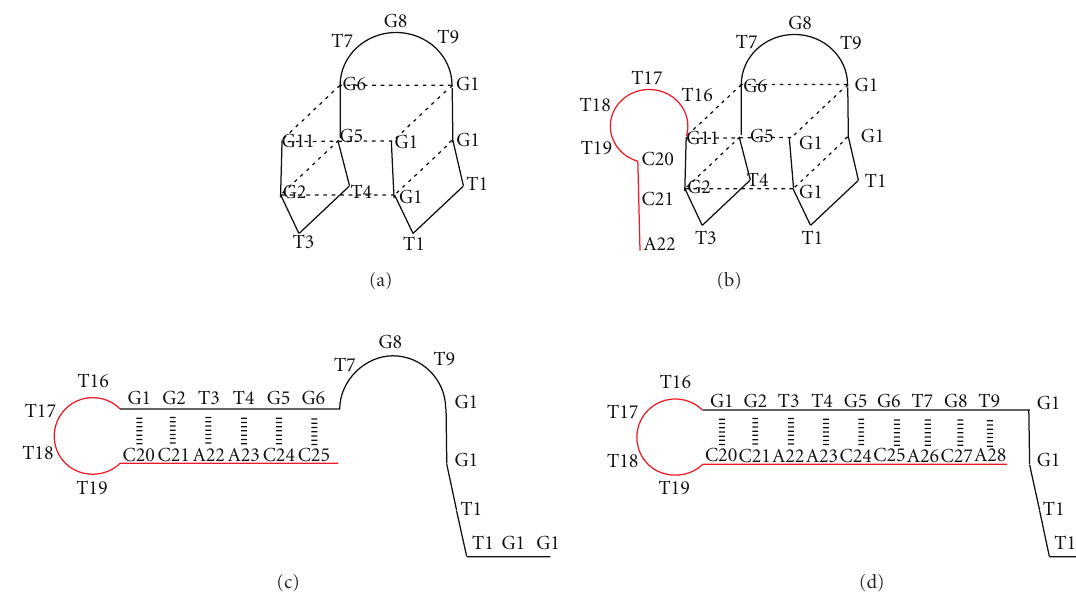
Figure 3: Schematic representation of the structure of several derivatives of thrombin-binding aptamers (TBAs) prepared in this study. TBA sequence is shown in black, and T4 loop with di ff erent sizes of the complementary sequences are shown in red. (a) Native TBA; (b) TBA-hairpin containing three overhanging complementary nucleotides (3-HP-TBA); (c) TBA-hairpin containing six overhanging complementary nucleotides (6-HP-TBA); (d) TBA-hairpin containing nine overhanging complementary nucleotides (9-HP-TBA).